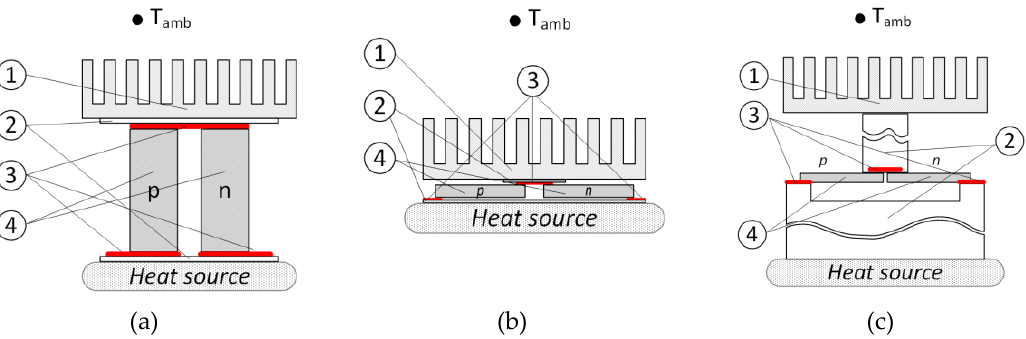
Figure 1. The typical topologies of thermoelectric elements: ( a ) traditional, ( b ) planar, and ( c ) on-chip planar. The common elements of the topologies are: (1) heatsinks, (2) electrically isolating thermal extenders, (3) electrical contact pads, and (4) thermoelectric pairs.